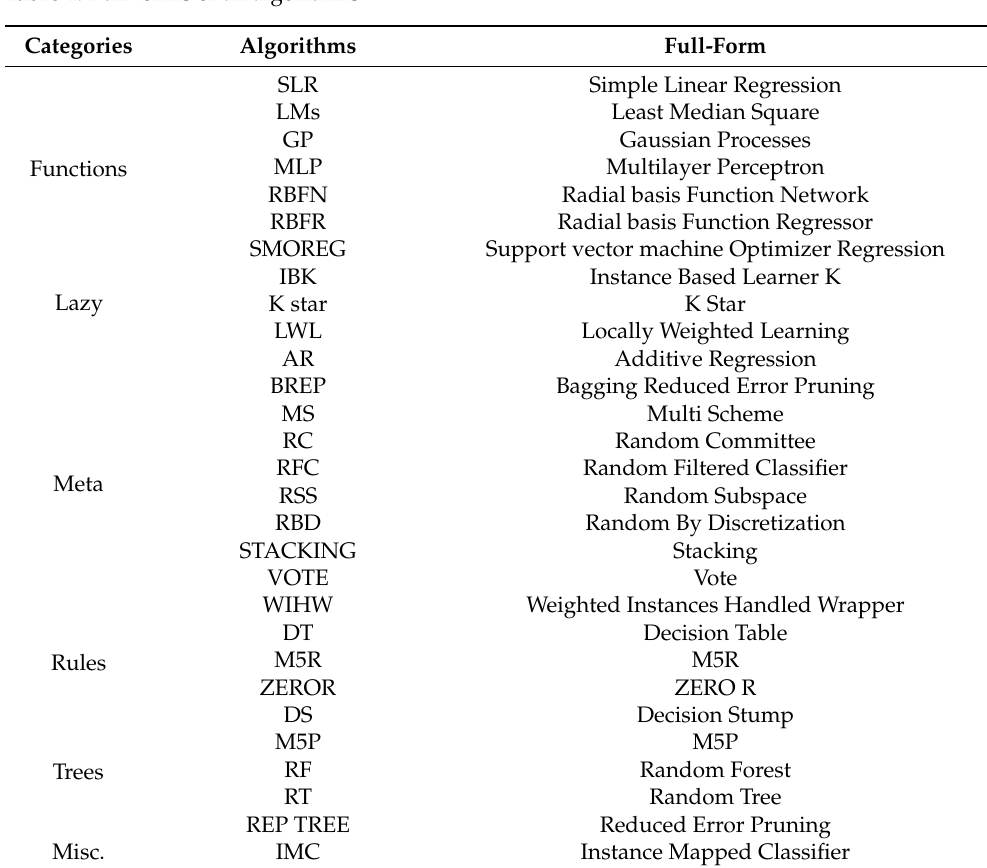
Table 4. Full forms of all